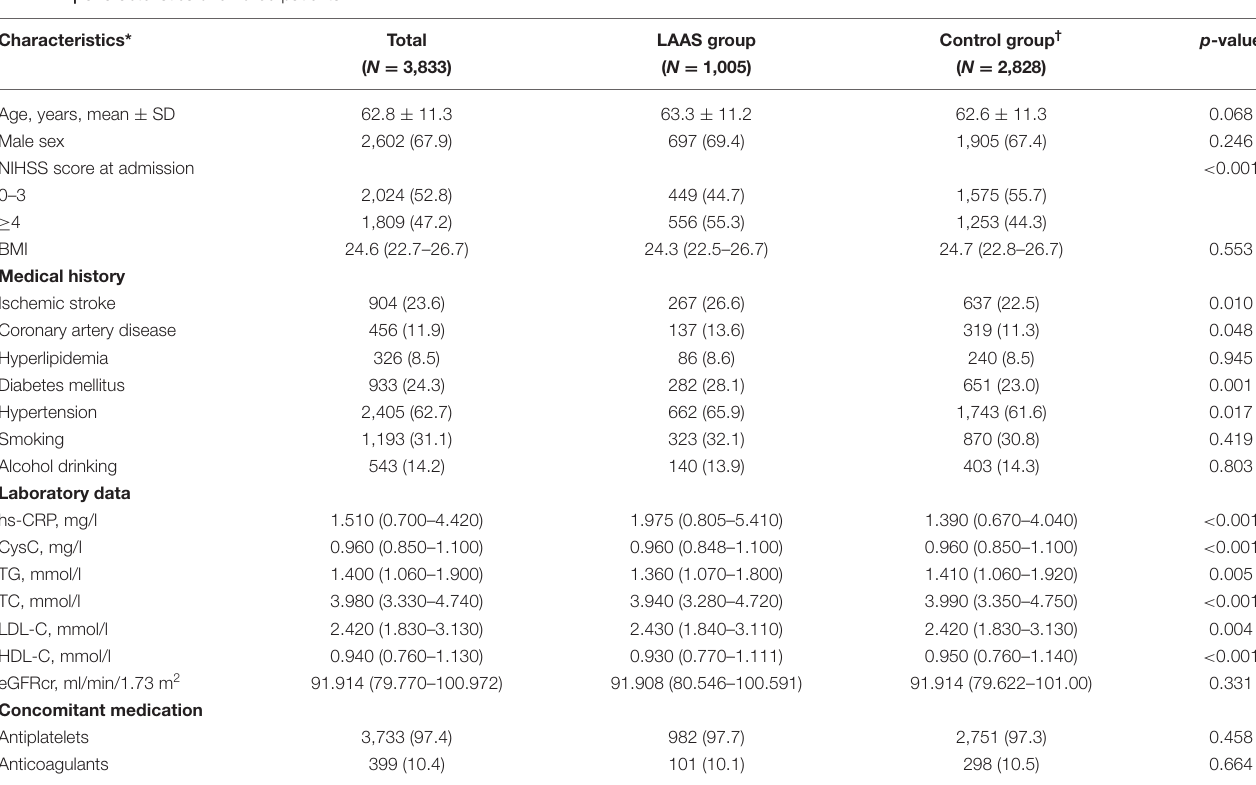
TABLE 1 | Characteristics of enrolled patients.